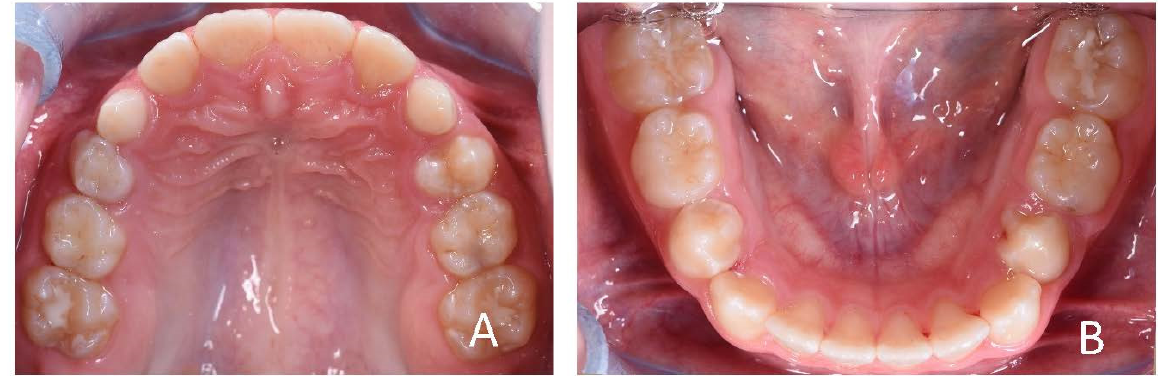
Figure 26. Intraoral photographs at the end of the treatment (9-year-old). ( A ) Frontal view; ( B , C ) lateral view.